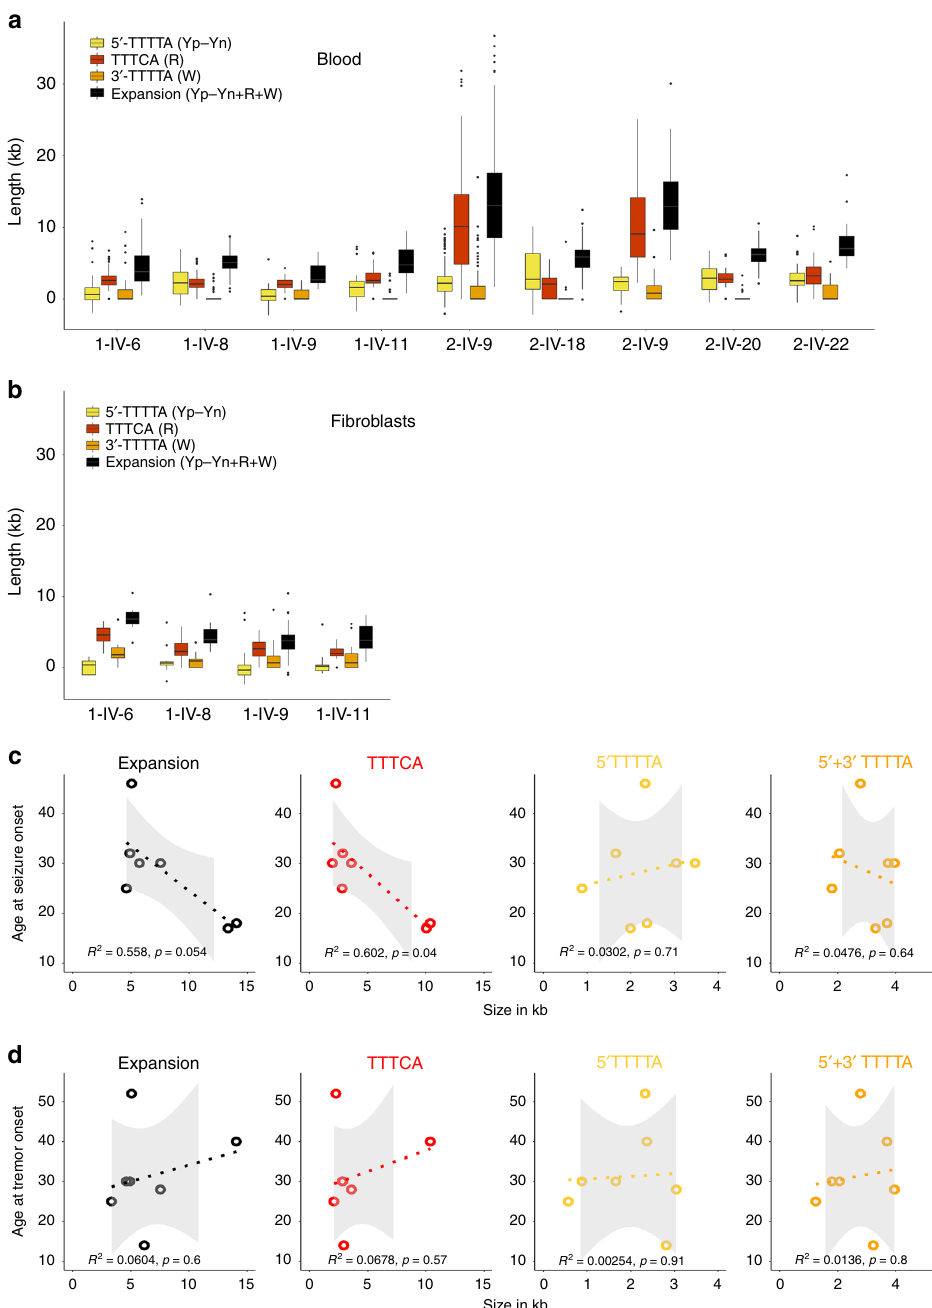
Fig. 5 Distribution of expansion lengths and genotype – phenotype correlations. a Box plots showing the distribution of the size of the overall expansion (in black), as well as the 5 ʹ -TTTTA (yellow, Yp – Yn; see Methods for details) and TTTCA (red, R) parts in blood from the nine carrier individuals. Some alleles showed an unstained part between the red and the green signals, which is referred to as 3 ʹ -TTTTA (W, in orange). Box plots elements are de fi ned as follows: center line: median; box limits: upper and lower quartiles; whiskers: 1.5× interquartile range; points: outliers. b Box plots showing the distribution of the size of the overall expansion (in black) and each parts: 5 ʹ -TTTTA appears in yellow (Yp – Yn; see Methods for details), TTTCA in red (R) in fi broblasts from four affected individuals of Family 1. c Correlations between the age at seizure onset and the mean size (in kb) of the overall expansion (left), the TTTCA (middle left), the 5 ʹ -TTTTA (middle right), or the overall (5 ʹ + 3 ʹ ) TTTTA repeats region (right). Individuals with larger TTTCA repeat region have an earlier age at seizure onset. On the contrary, neither the size of 5 ʹ -TTTTA or 5 ʹ + 3 ʹ -TTTTA repeats correlate with the age at epilepsy onset. Individuals included in the graph are 1-IV-6, 1-IV-8, 1-IV-11, 2-IV-9, 2-IV-18, 2-V-9, and 2-V-22. Individuals without epilepsy also have the smallest TTTCA stretches although they are not included (see Table 1). R 2 is the square value of the Pearson coef fi cient; 95% con fi dence intervals appear in gray; corresponding R values and 95% con fi dence intervals are summarized in Supplementary Table 2. d Correlations between the age at tremor onset and the mean size (in kb) of the expansion and each part, showing no correlation with any of them. Individuals included in the graph are 1-IV-6, 1-IV-8, 1-IV-9, 1-IV-11, 2-IV-9, 2-V-20, and